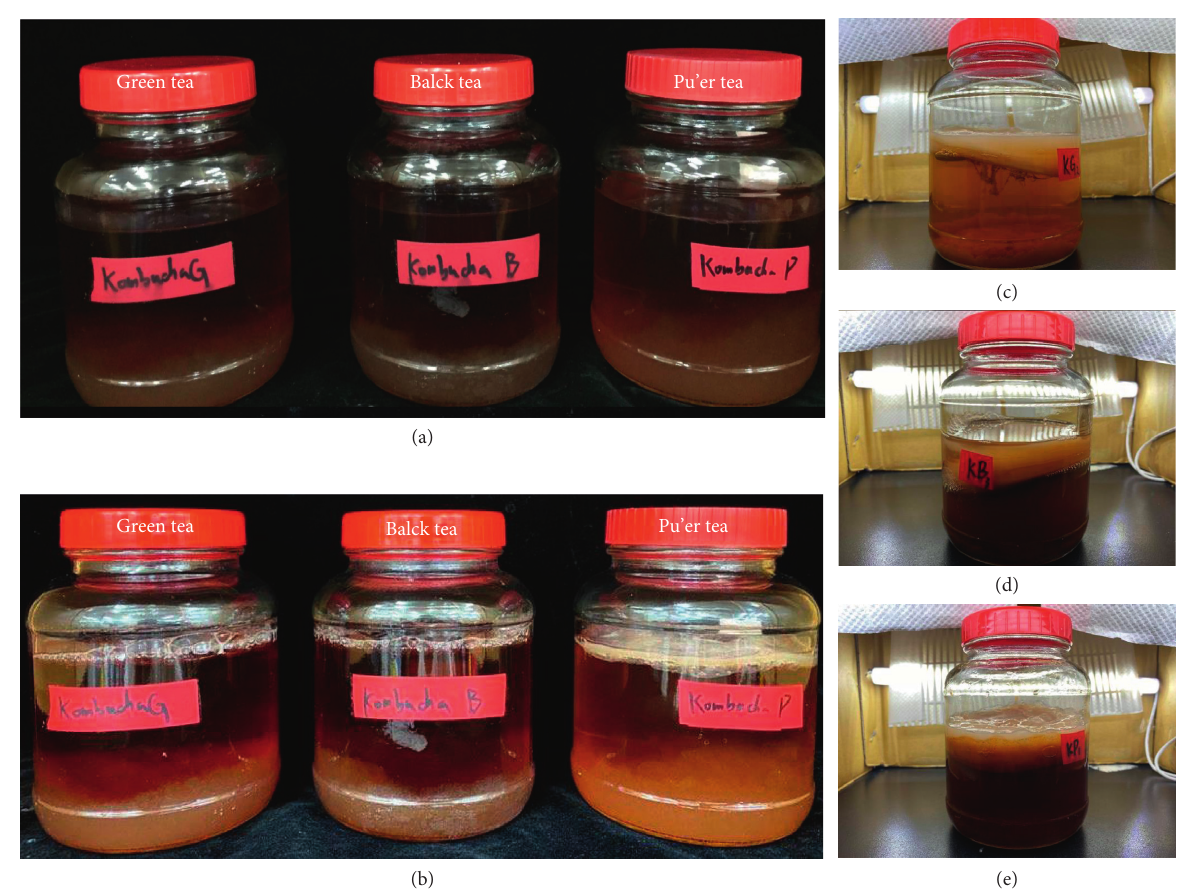
Figure 1: Appearance of kombucha prepared from green tea, black tea, and pu’er tea (from left to right) at the beginning of the fermentation process (a) and after 12 days of fermentation (b). After 20 days of fermentation, the kombucha tea prepared from black tea showed a dark- brown color, whereas the kombucha tea that was prepared from the green tea and pu’er tea displayed a color between tan brown and creamy white ((c) green tea; (d) black tea; (e) pu’er tea).